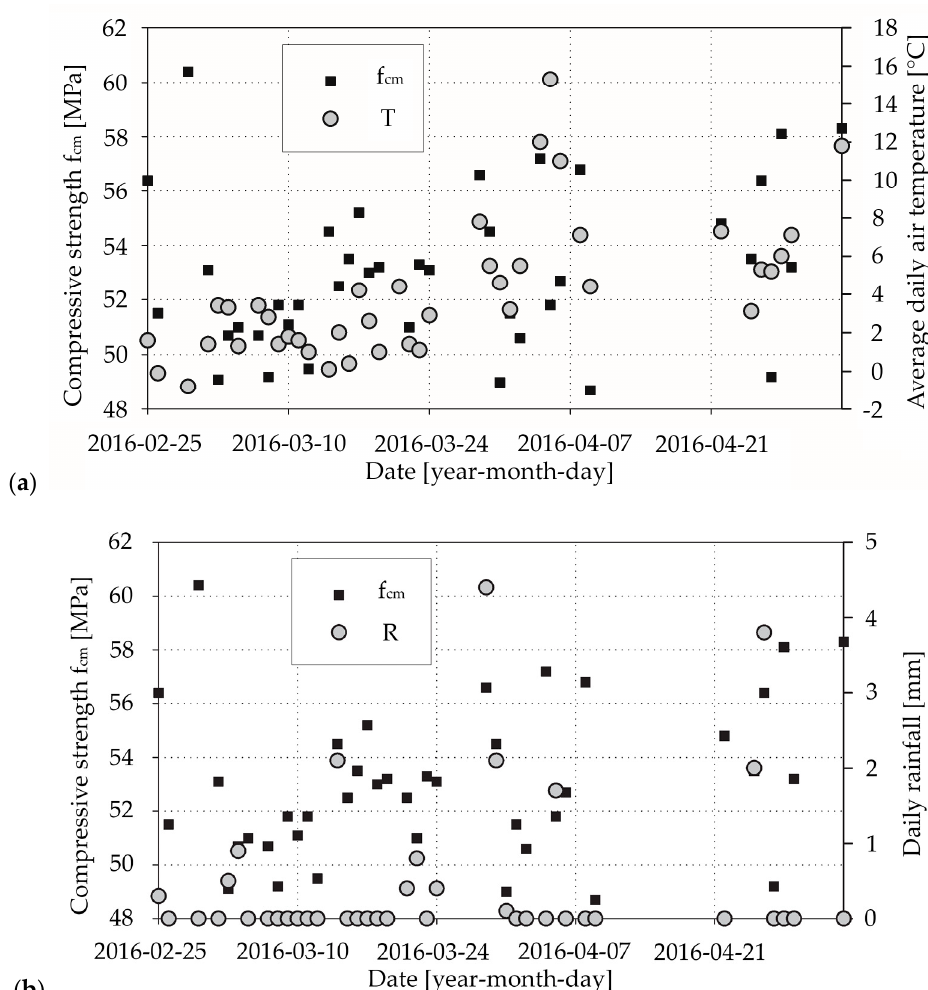
Figure 3. Laboratory test results for concrete mix CM_Aw type: ( a ) compressive strength and corresponding average daily air temperatures; ( b ) compressive strength and corresponding daily rainfall.